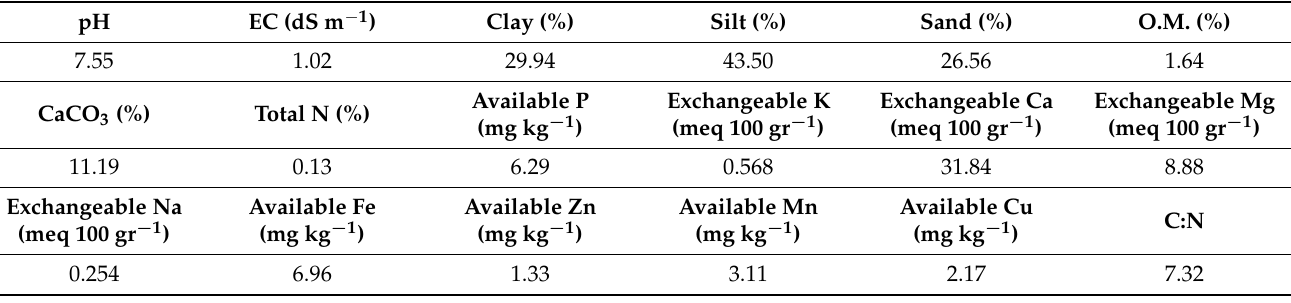
Table 2. Some properties of experiment